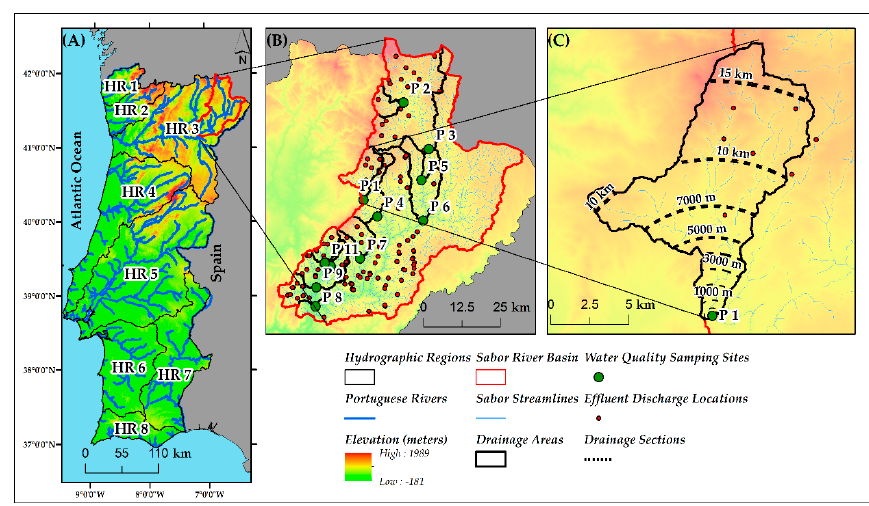
Figure 1. ( A ) Distribution of hydrographic regions in Portugal. ( B ) Sabor River Basin, water quality sampling sites, and effluent discharge sites. ( C ) Drainage area of sampling site P1 and drainage sections.